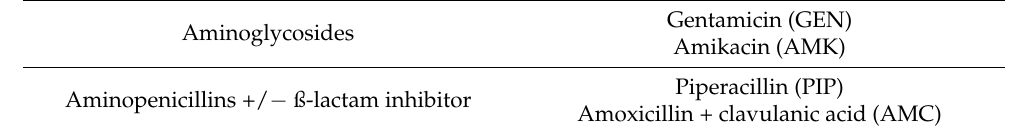
Gentamicin (GEN) Amikacin (AMK) Due to the different composition of the antibiotic rings, various cephalosporins are grouped together under this heading (including cefuroxime, cefazolin, and ceftriaxone). A separate evaluation was not possible because of the inconsistent documentation. Ciprofloxacin (CIP) Levofloxacin